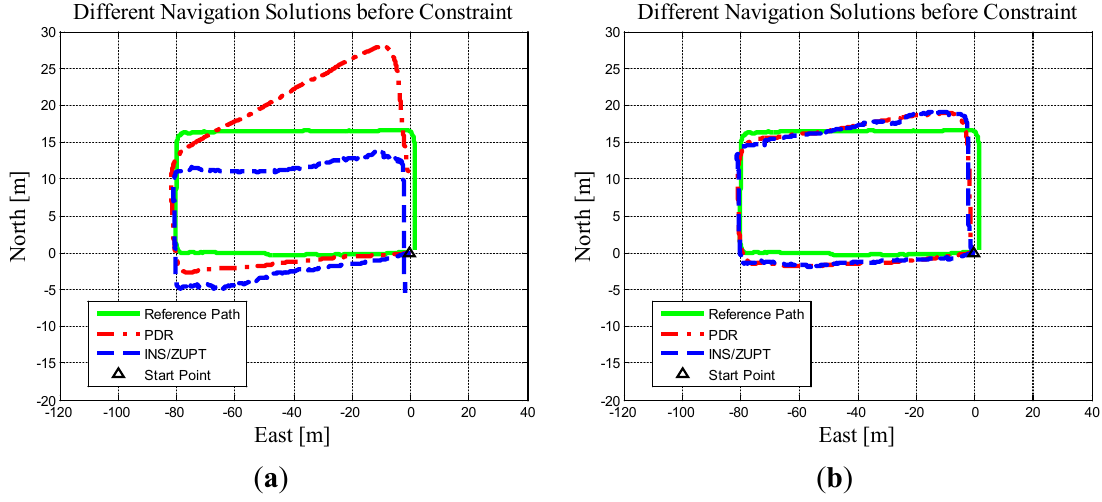
Figure 10. Trajectory III: Two systems’ navigation solutions. ( a ) Before constraint; ( b ) After